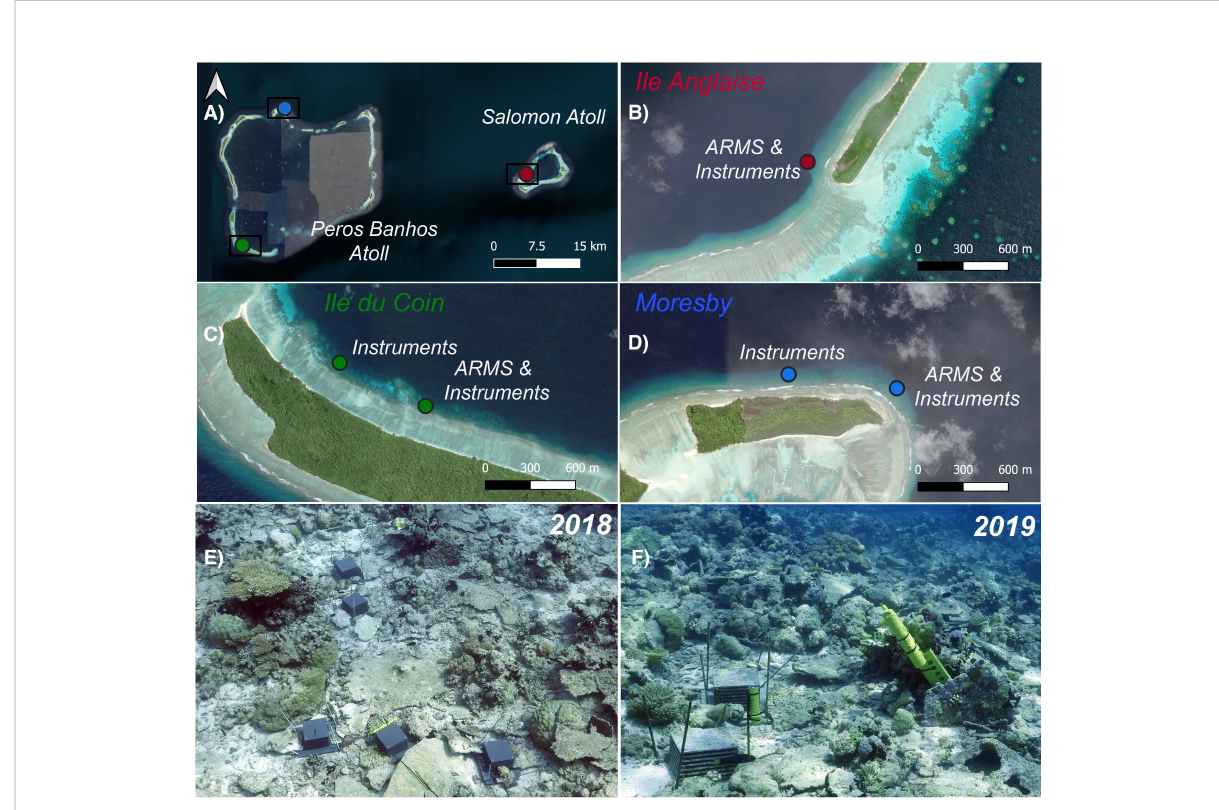
FIGURE 1 Maps displaying the location of (A) sampling sites across Peros Banhos and Salomon atolls in the Chagos Archipelago marine-protected area (MPA), (B) autonomous reef monitoring structures (ARMS) and environmental instruments at Ile Anglaise, (C) ARMS and environmental instruments at Ile du Coin, and (D) ARMS and environmental instruments at Moresby Island. (E) ARMS devices and environmental instruments at Ile Anglaise in 2018 following deployment and (F) ARMS devices and instruments at the same site in